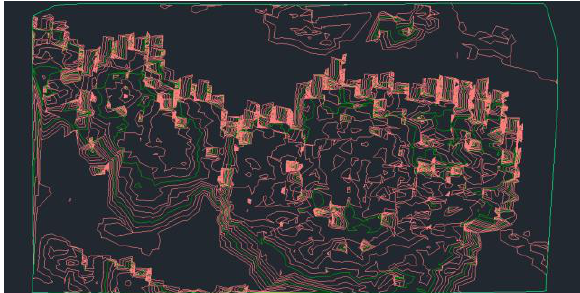
Figure 6. A topographic view from the multi trunk trees. The contour lines clearly show multiple peak point.